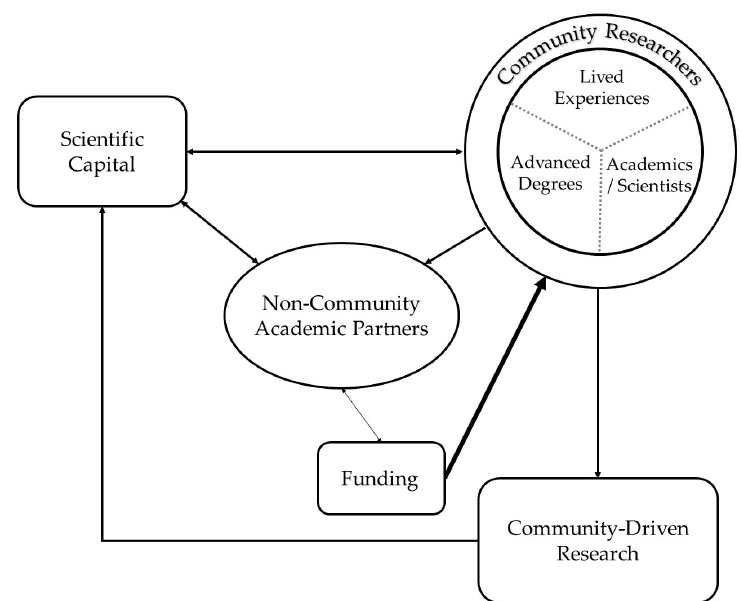
Figure 2. Community as the key metric for organizing community-driven research. Community researchers include individuals who have lived experiences in the community, advanced degrees and certifications, or who may be academics and scientists. Non-community academic partners are distinct from community researchers in their lack of community identity. Community-driven research may be carried out in partnership with non-community academics, however, community researchers should drive the direction of the research. Funding opportunities can and should come to non-community academics, but funding priorities should emphasize resources provided to community researchers, which we have indicated with a thicker